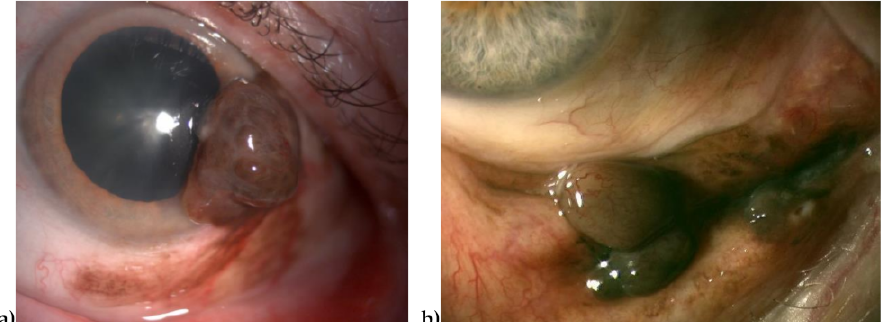
Figure 1. Two pictures of ConjMel originating at the limbus, from primary acquired melanocytosis (( a ) case #4), and inferior fornix (( b ) case